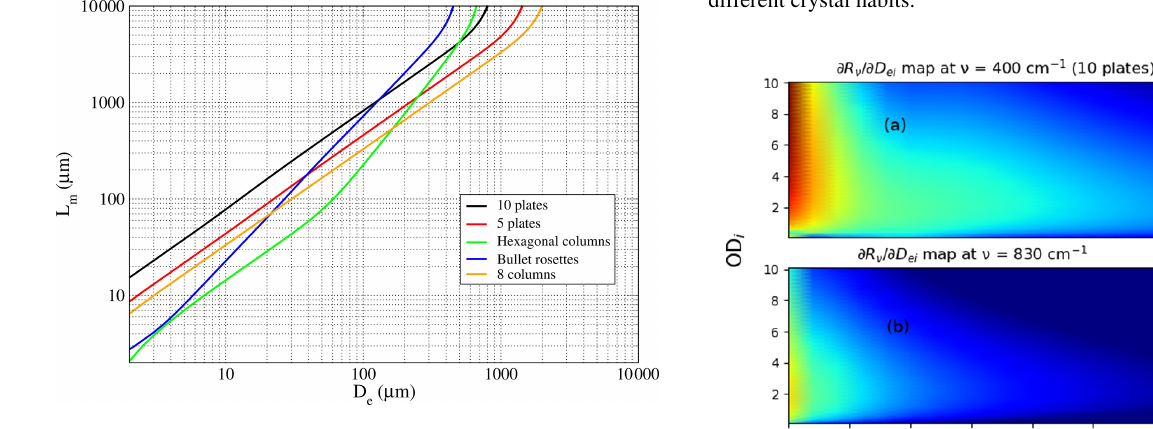
Figure 5. Relationship between the effective diameter ( D ei ) and the modal radius ( L m ) of the particle size distribution for the various ice crystal habits.